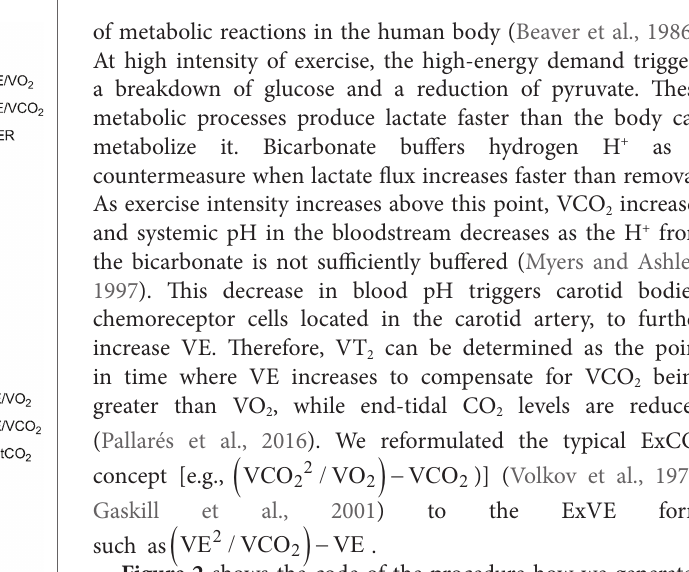
pressure of O 2 (green dots); end-tidal pressure of CO 2 , PETCO 2 (pink dots). Finally, we identified the work rate associated